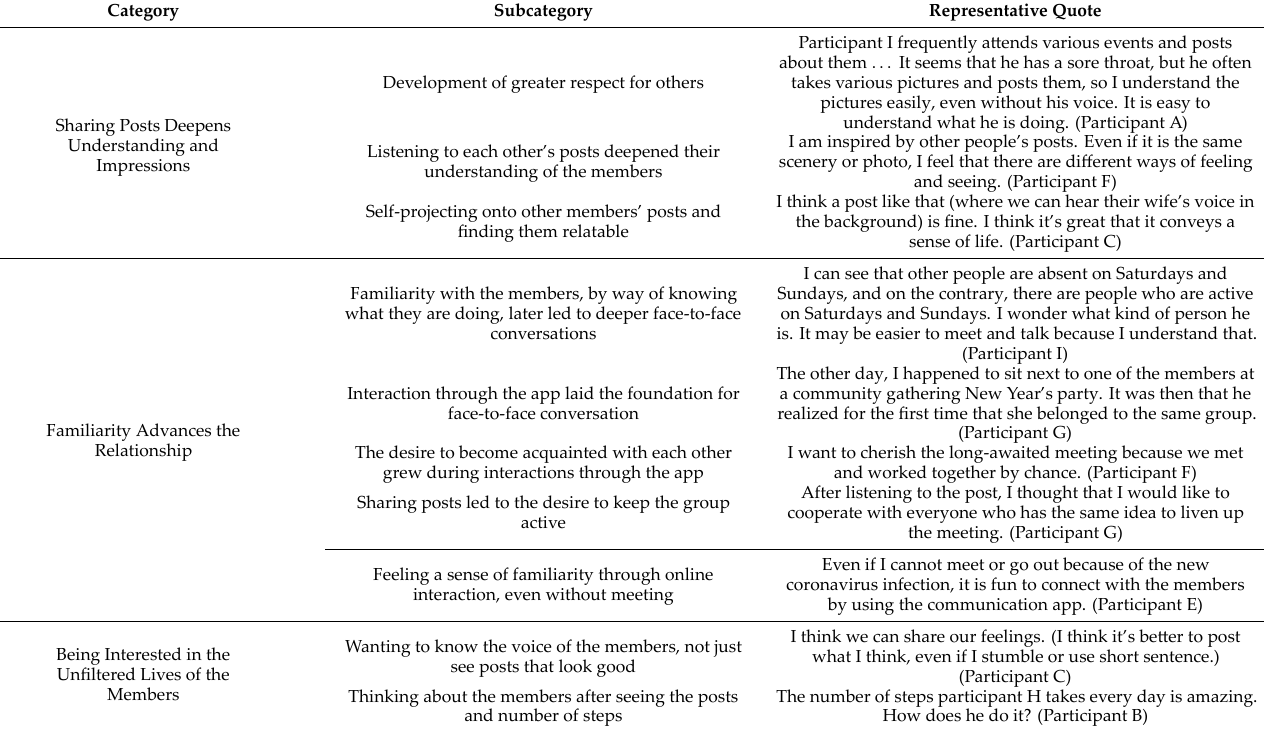
Table 3. Themes and subthemes representing social connectedness established through the